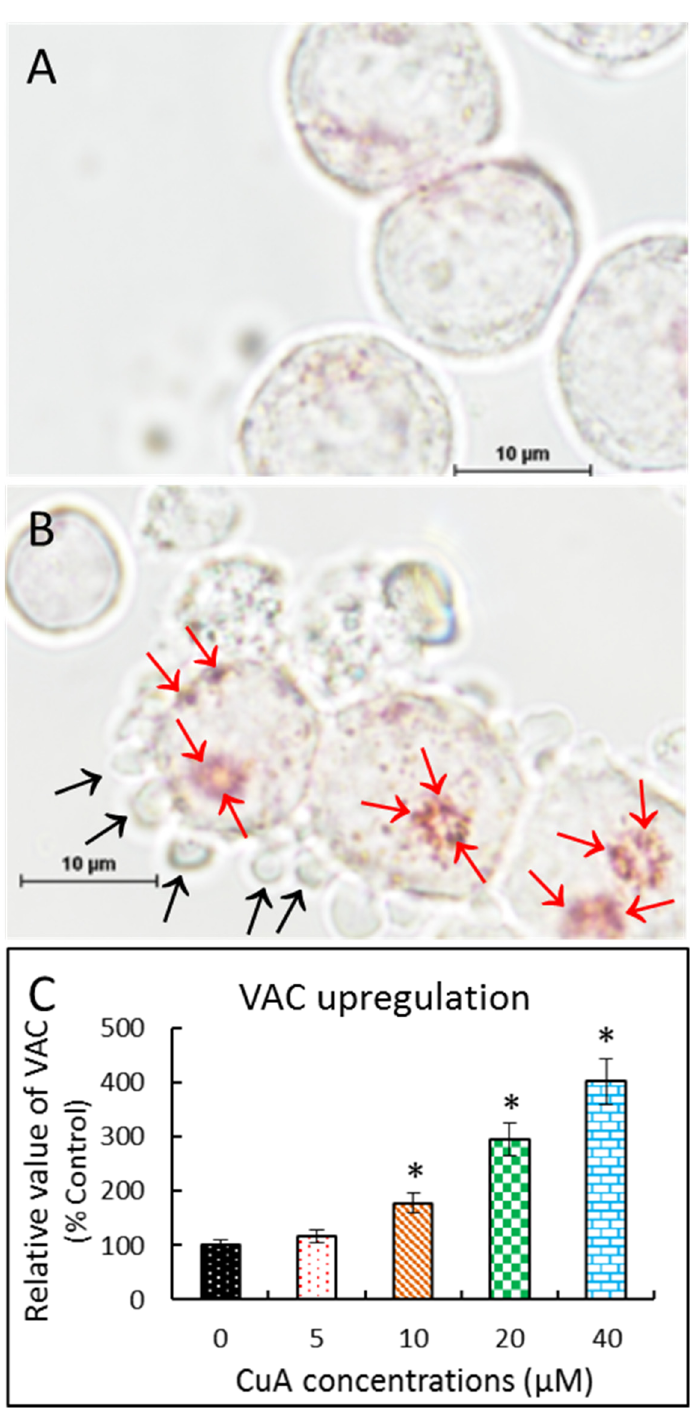
Figure 3. Cuminaldehyde increased the volume of the acidic compartment in human colorectal COLO 205 cells. After treatment without and with 20 μ M cuminaldehyde, respectively, for 48 h, human colorectal COLO 205 cells were stained using neutral red. ( A ) Human colorectal COLO 205 cells without treatment: There were no observable vacuoles in the cell; ( B ) Human colorectal COLO 205 cells treated with cuminaldehyde at the concentration of 20 μ M for 48 h. The blebbing (black arrows) and acidic red ‐ stained vacuoles (red arrows) in cells happened; ( C ) Cuminaldehyde increased volume of acidic compartment in a quantity ‐ dependent manner. After treating the cells using the specified concentrations of cuminaldehyde for 48 h, results were evaluated by a spectrophotometer. Results are shown by means plus/minus standard error of the mean, n equal to 3. *, Statistically significant ( p less than 0.05) from the control group. CuA, cuminaldehyde.